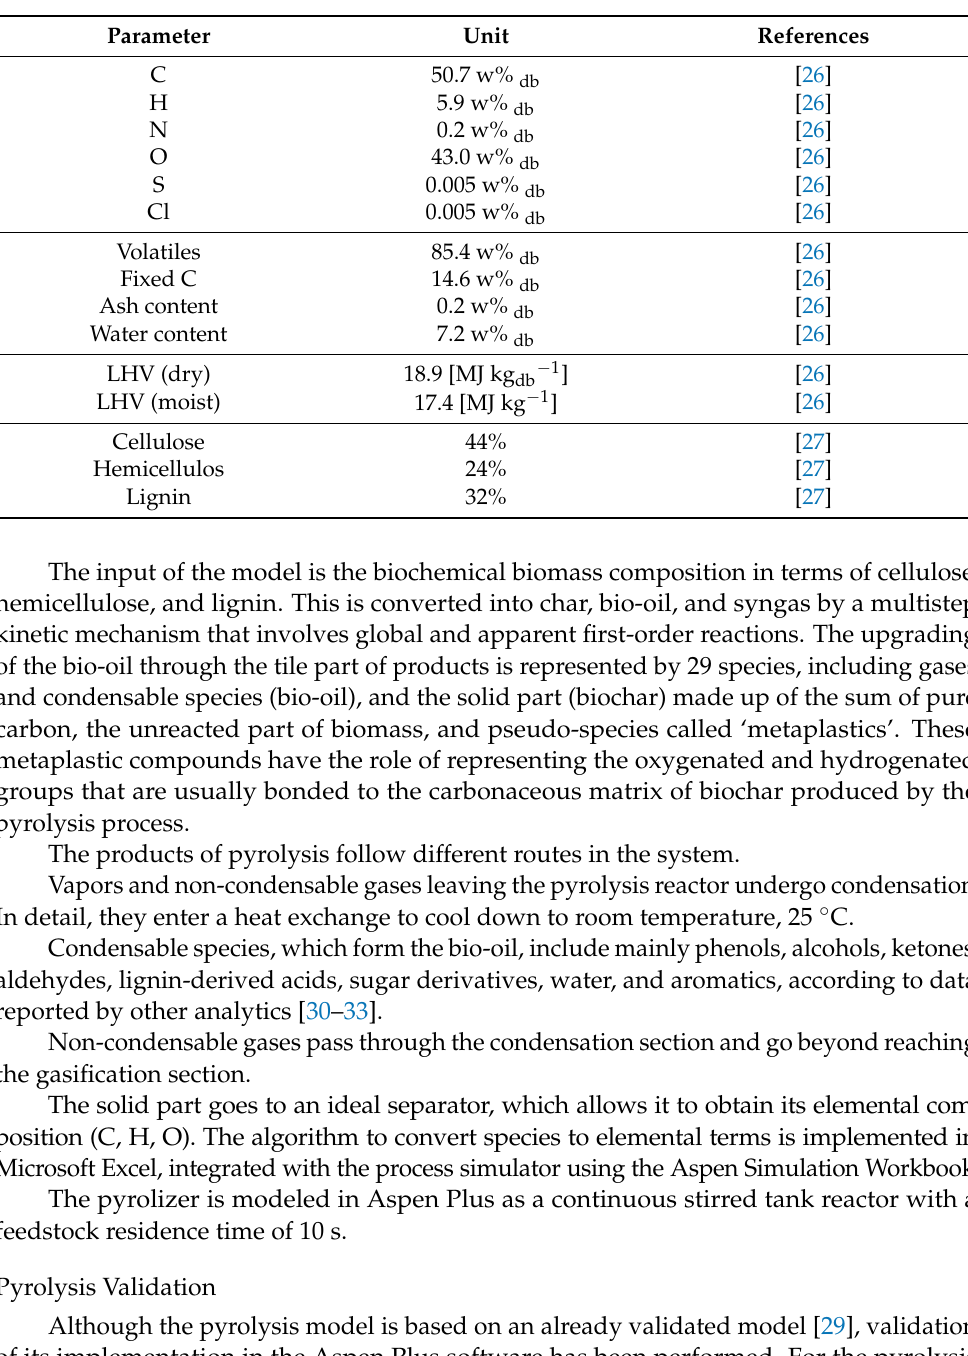
Table 1. Characterization of softwood: elemental and proximate analysis, determination of low heating value and polymeric